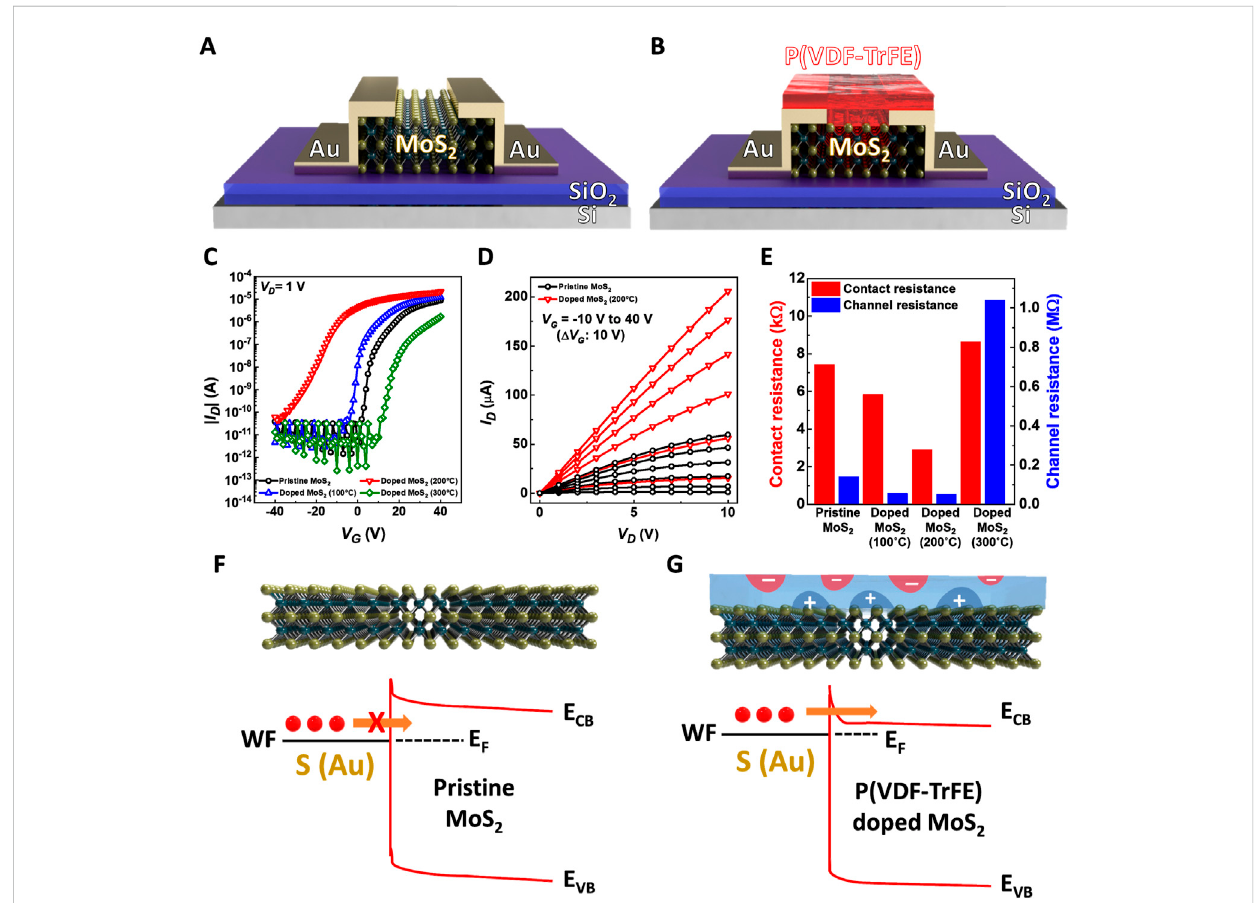
FIGURE 2 3D schematic diagram of the (A) pristine and (B) P(VDF-TrFE)-doped MoS 2 FET. (C) Transfer curves of the pristine MoS 2 FET and the P(VDF-TrFE)- doped MoS 2 FETs (100, 200, and 300 ° C). (D) Output curves of the pristine MoS 2 FET and P(VDF-TrFE)-doped MoS 2 FET (200 ° C). (C) Contact resistance and channel resistance of the pristine MoS 2 FET and the P (VDF-TrFE)-doped MoS 2 FETs (100, 200, and 300 ° C) extracted by the G-function method. (F) Energy band diagram of the pristine MoS 2 FET. (G) Energy band diagram of the P(VDF-TrFE)-doped MoS 2